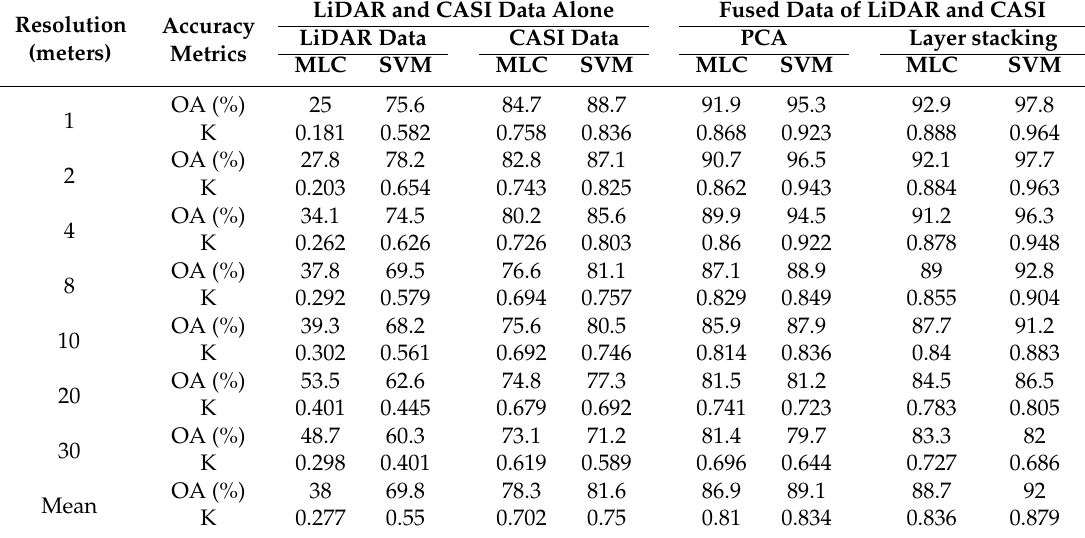
Table 3. Classification accuracies of the maximum likelihood classification (MLC) and support vector machine (SVM) classifiers using four types of datasets with different spatial resolutions. The accuracy metrics included the overall accuracy (OA) and kappa coefficient